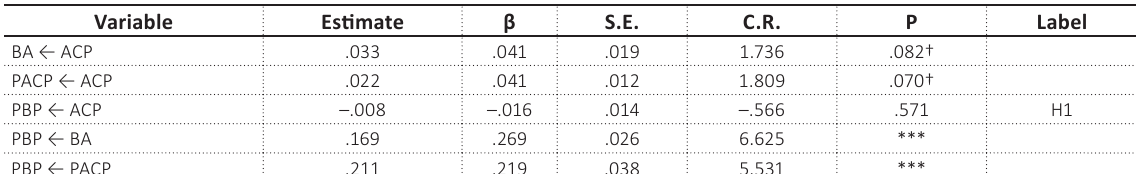
Table 3. Regression weights